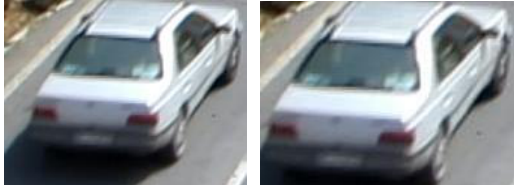
Figure 7. Vehicle bounding box before (left) and after (right) shadow elimination. Table 5. Importance of shadow elimination in BoW scores for the vehicle of figure 7 (Peugeot 405).